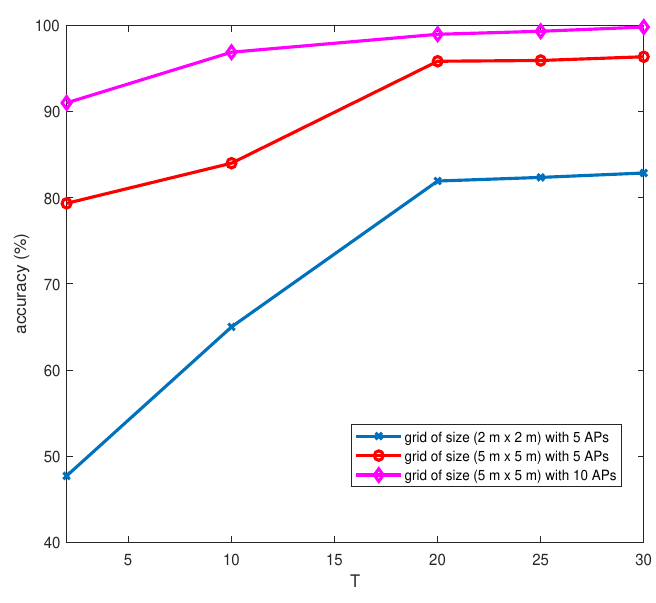
Figure 7. Variation of the accuracy depending on the parameter T .